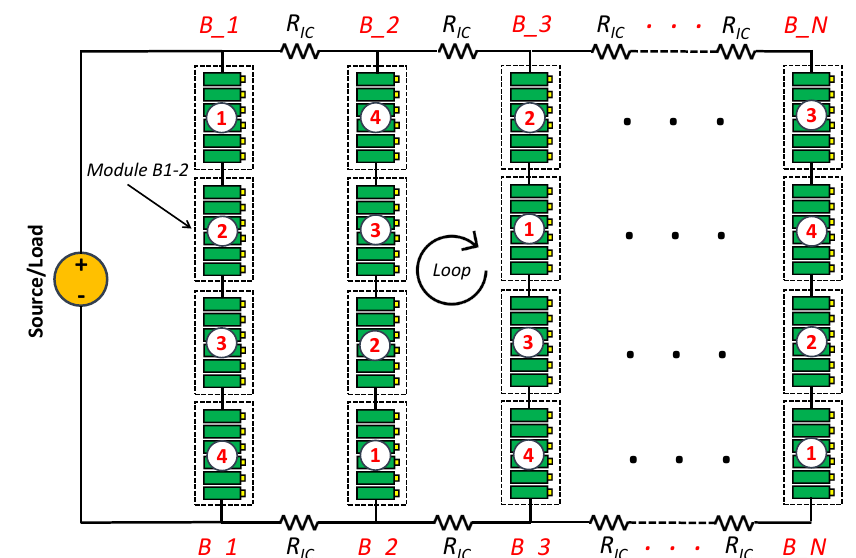
Figure 2. A schematic representation of the module-to-module discretization method for the battery